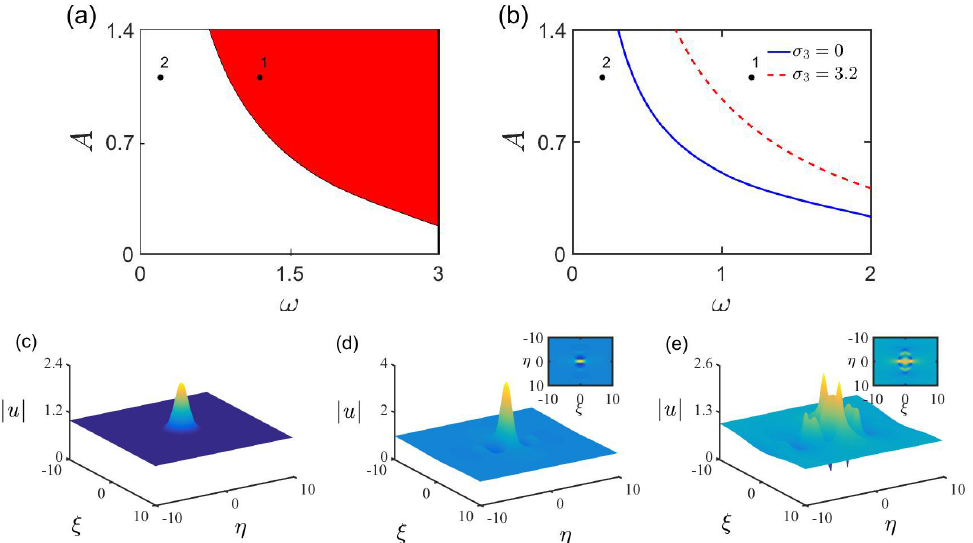
Figure 4. (Color online) ( a ) The existence regions of nonlinear modes as functions of A and ω when C = 1. The red region is for high-dimensional rogue waves. ( b ) The phase-transition curves of high-dimensional rogue waves for the SNLSE (11) with σ 3 = 0 (blue solid line) and 3.2 (red dotted line). The regions containing point 1 denote the existence interval of high-dimensional rogue waves. ( c – e ) The profiles of nonlinear modes by taking s = 0, 0.99, and 1.61, respectively. Here, ω =